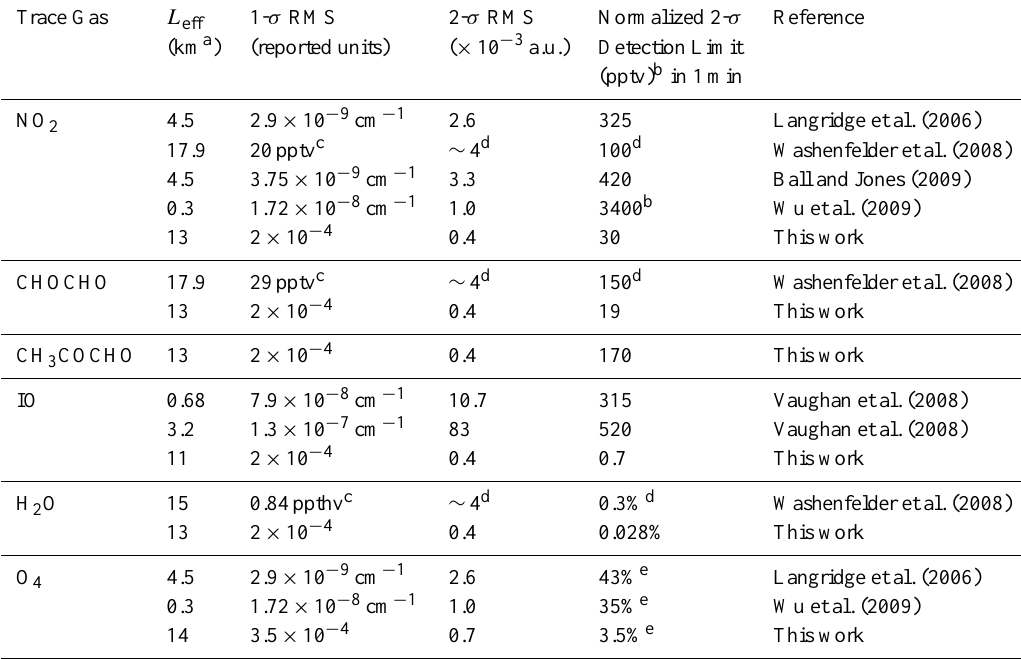
Table 4. Normalization and comparison of detection limits for trace gases measured with blue CEAS instruments. Trace Gas L